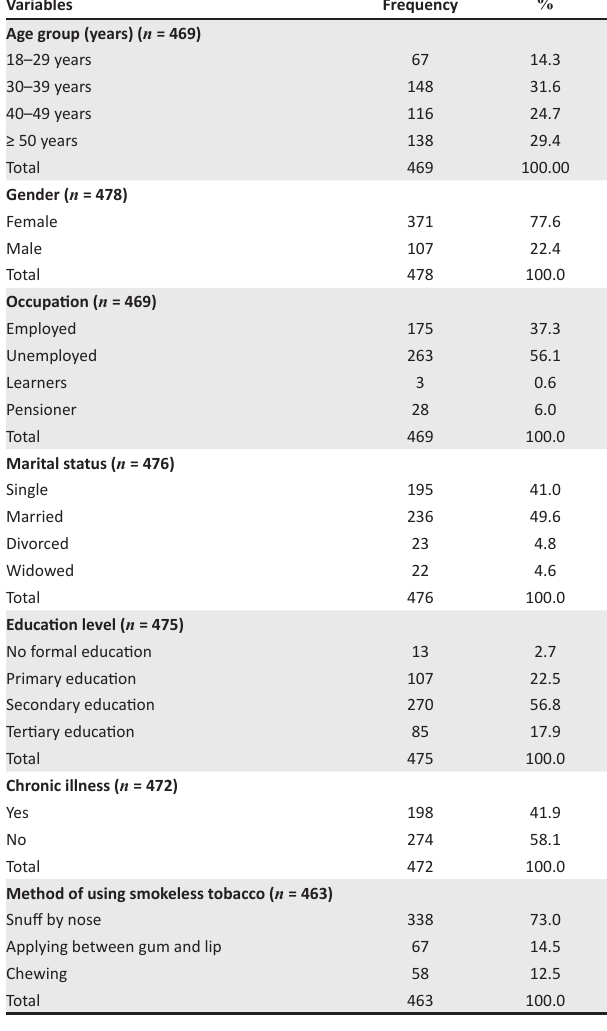
TABLE 1: Socio-demographics.